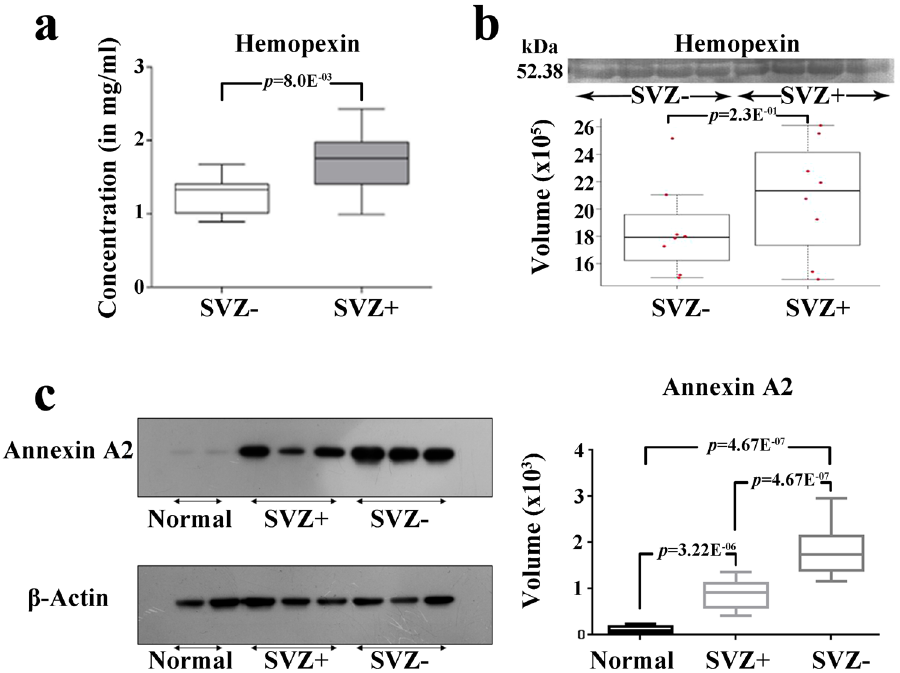
Figure 4. Validation of significantly altered serum (hemopexin-HPX) and tissue (annexin A2-ANXA2) proteins in SVZ + and SVZ − GBMs. ( a ) Box plots representing the serum levels of HPX in SVZ − (n = 10) and SVZ + (n = 10) GBMs estimated using ELISA and ( b ) western blotting results representing the serum levels of HPX in SVZ − (n = 8) and SVZ + (n = 8) GBMs. ( c ) Validation of ANXA2 levels in normal brain tissue (n =